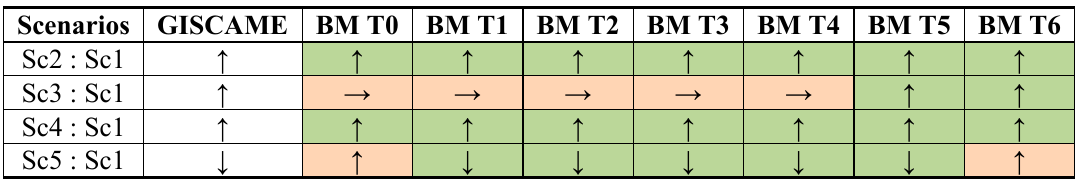
Table 3. Comparison of the ecosystem service “wood production” of GISCAME with the “Yield” of the Biomass Module: Scenarios (Sc) 2, 3, 4, and 5 are compared to scenario 1 (reference scenario). Positive ( ↑ ), negative ( ↓ ) and no trends ( → ) are identified. Green fields indicate consistent trends of GISCAME and Biomass Module; red fields